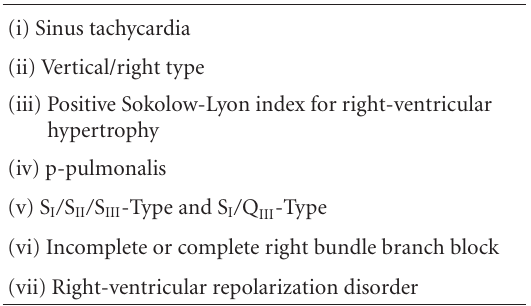
Table 6: ECG-findings in chronic right-heart failure.